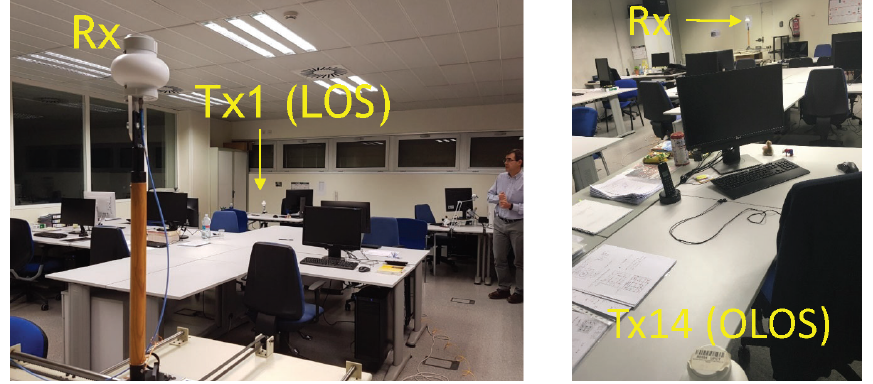
Figure 5. Top view of the propagation environment.